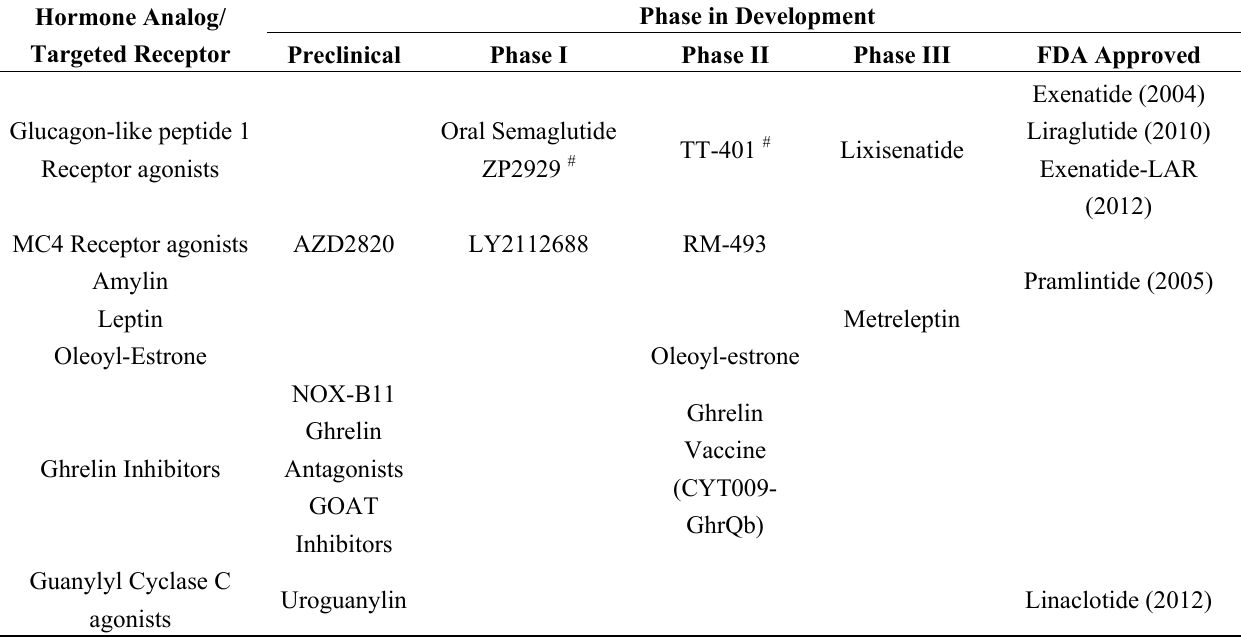
Table 1. Current state of pharmacotherapeutic options targeting gut-brain endocrine axes. This table summarizes the pipeline of pharmacologic agents that target various gut-brain endocrine axes related to satiety. All therapeutic agents are administered subcutaneously unless noted otherwise. # GLP-1R and glucagon-R